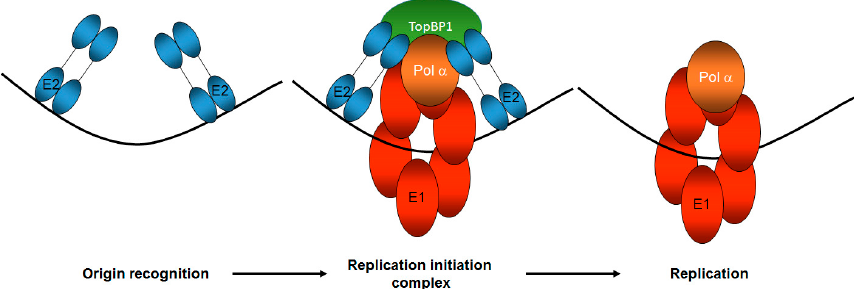
Figure 2. TopBP1 is a key component of correct HPV E1–E2 mediated DNA replication. The E2 protein recognizes the viral origin of replication (represented by the black line) and therefore serves as the viral origin recognition complex. It then recruits a host of proteins to the origin via protein-protein interactions, including the viral helicase E1 and TopBP1 , to form the replication initiation complex. TopBP1 can interact with both E2 and E1 and is known to recruit DNA polymerases to mammalian replication complexes. Following the initiation of replication, the E1 helicase and host polymerases can then begin to replicate the viral genome. The number and function of host proteins required for